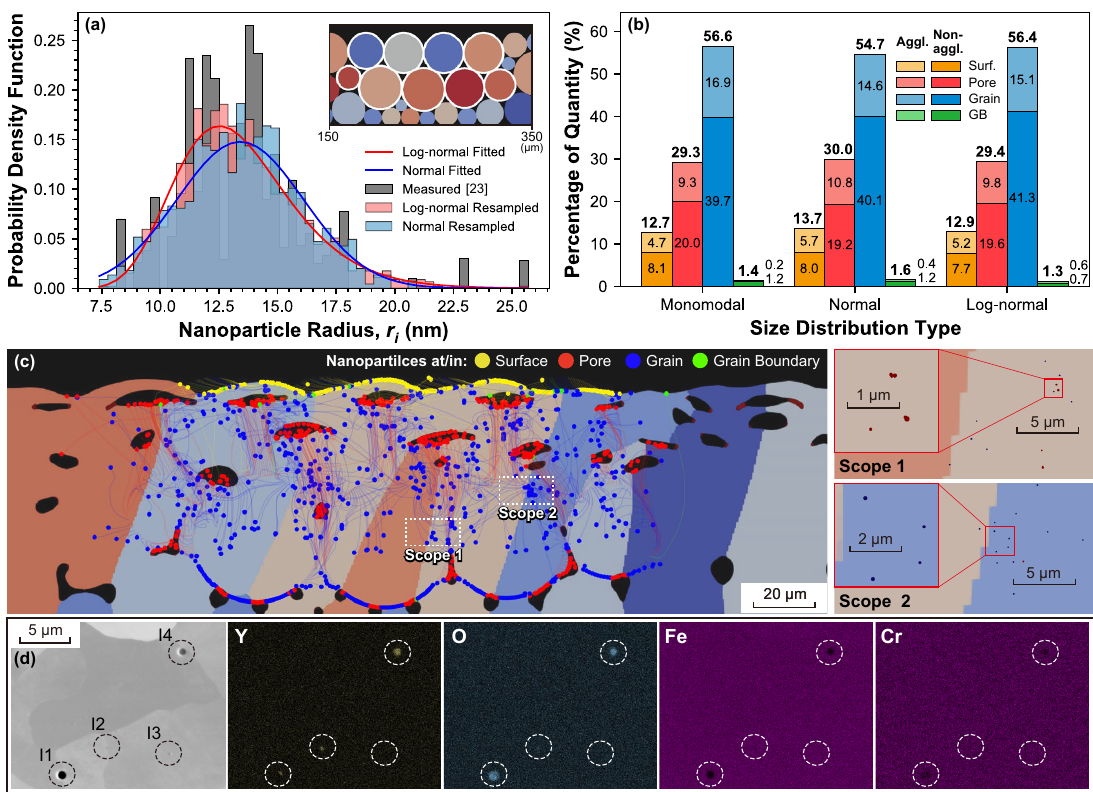
Figure 5. ( a ) Size distributions of nanoparticles. Inset: selected parent particles. ( b ) Statistics of drift destinations of nanoparticles with respect to distinct size distributions, presented as the percentage of quantity to the total amount of decorated nanoparticles, i.e., N p = 1240, with the ones of agglomerated/non-agglomerated nanoparticles also presented as the component for each destination genre; ( c ) dispersion of traced Y 2 O 3 nanoparticles with the log-normal size distribution in the LPBF-processed PM2000 polycrystal matrix (left) and regional magnification of dispersed nanoparticles in selected scopes (Scope 1 and 2) in realistic scale (right). Magnified scopes are employed to distinguish the occurrence of agglomeration from the enrichment, which is inaccessible in the trajectory illustration on the left. ( d ) SEM backscatter electron imaging with the corresponding EDX maps of the elemental Y, O, Fe, and Cr content in four inclusions (I1-I4) for identifying nanoparticle agglomeration. I3 is not agglomerated nanoparticles due to a lack of Y content, while I1 implies agglomerated nanoparticles on the surface of another oxide inclusion. The magnified scope in ( c ) right is also compared to the SEM imaging in ( d ), demonstrating relatively larger nanoparticle agglomeration (I4) spotted in experimental observation, while I2 shows almost a consistent scale to the simulated